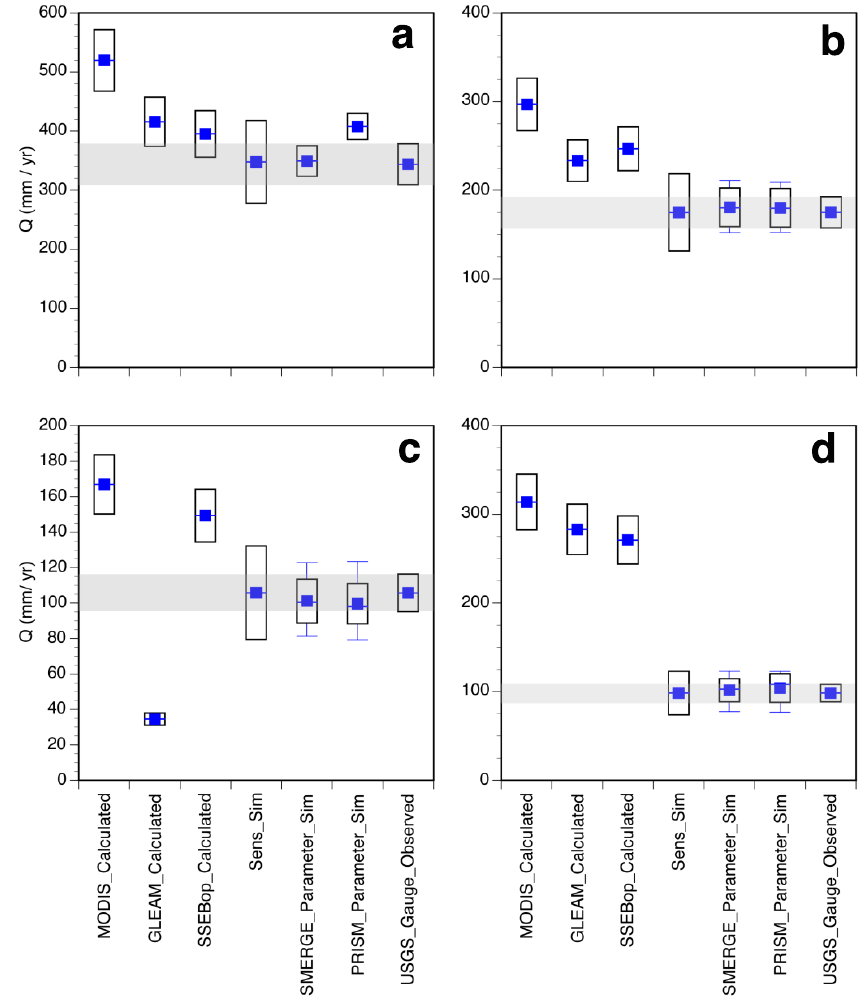
Figure 5. Observed USGS, mass balance calculated with the Moderate Resolution Imagining Spectrometer, MODIS16A2v5 (MODIS), Global Land Evaporation: the Amsterdam Model (GLEAM), Simplified Surface Energy Balance (SSEBop), and final calibration year-by-year SWAT simulated (Sens_Q, SMERGE_Parameter, PRISM_Parameter) streamflow (Q). Gray field indicates nominal ± 10% error of USGS streamflow observations. ( a ) BC-2017, ( b ) BV-2016, ( c ) BV-2017, and ( d ) BV-2018.